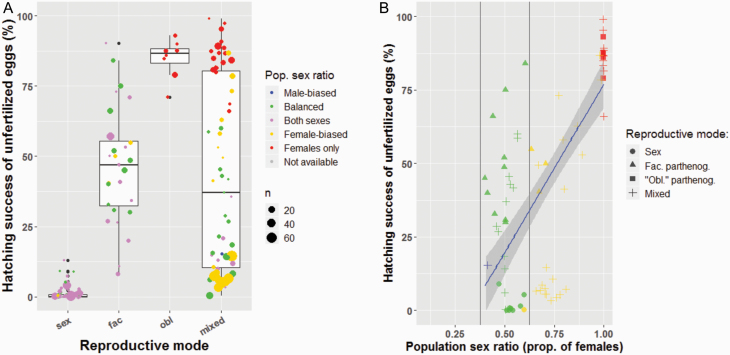
(A) Population-average hatching success of unfertilized eggs and reproductive modes. x axis: sex: sexual reproduction, fac: facultative parthenogenesis, obl: “obligate” parthenogenesis, mixed: mixed reproduction (in sympatry and/or in allopatry). Pop. sex ratio: population sex ratio. Both sexes (purple dots) means that males are present in these populations, but exact sex ratios were not recorded; n: number of females used for determining the egg-hatching success in a given population. In total, 186 populations from 108 different species are represented (with species from 17 families but mostly Baetidae (32.3%) and Heptageniidae (27.4%), see also Supplementary Figures 1 and 2). (B) Population-level correlation between unfertilized egg-hatching success and sex ratio (GLMM, r = 0.72, P-value < 0.001). Sex: sexual reproduction, Fac. parthenog.: facultative parthenogenesis; “Obl.” parthenog.: “obligate” parthenogenesis, Mixed: mixed reproduction (in sympatry and/or in allopatry). Data are available for 84 populations from 31 species (with species from 11 families but mostly Baetidae (23.8%) and Heptageniidae (20.2%), see also Supplementary Figures 3 and 4).